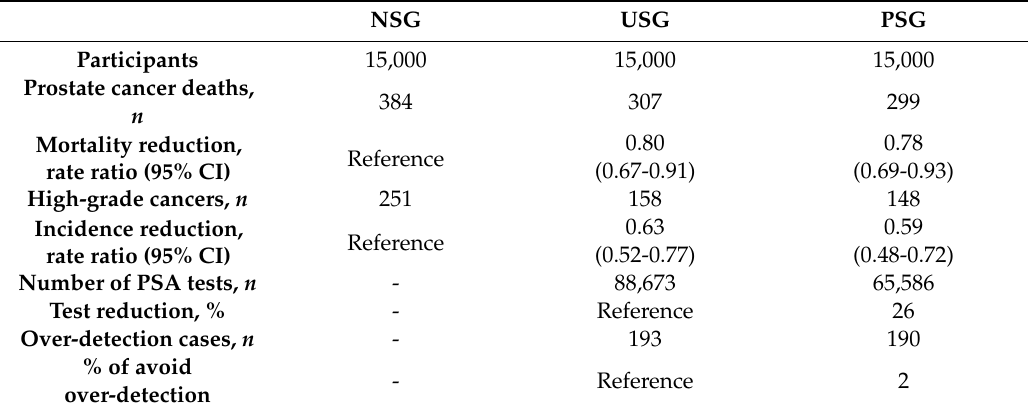
Table 4. Simulated results of no screening, universal, and gene-PSA personalized prostate cancer